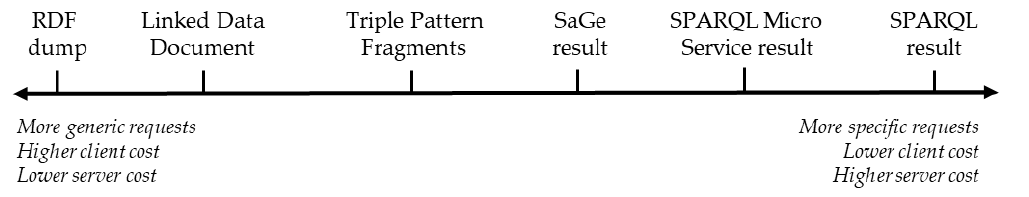
Figure 3. Granularity of different types of Linked Data Fragments .